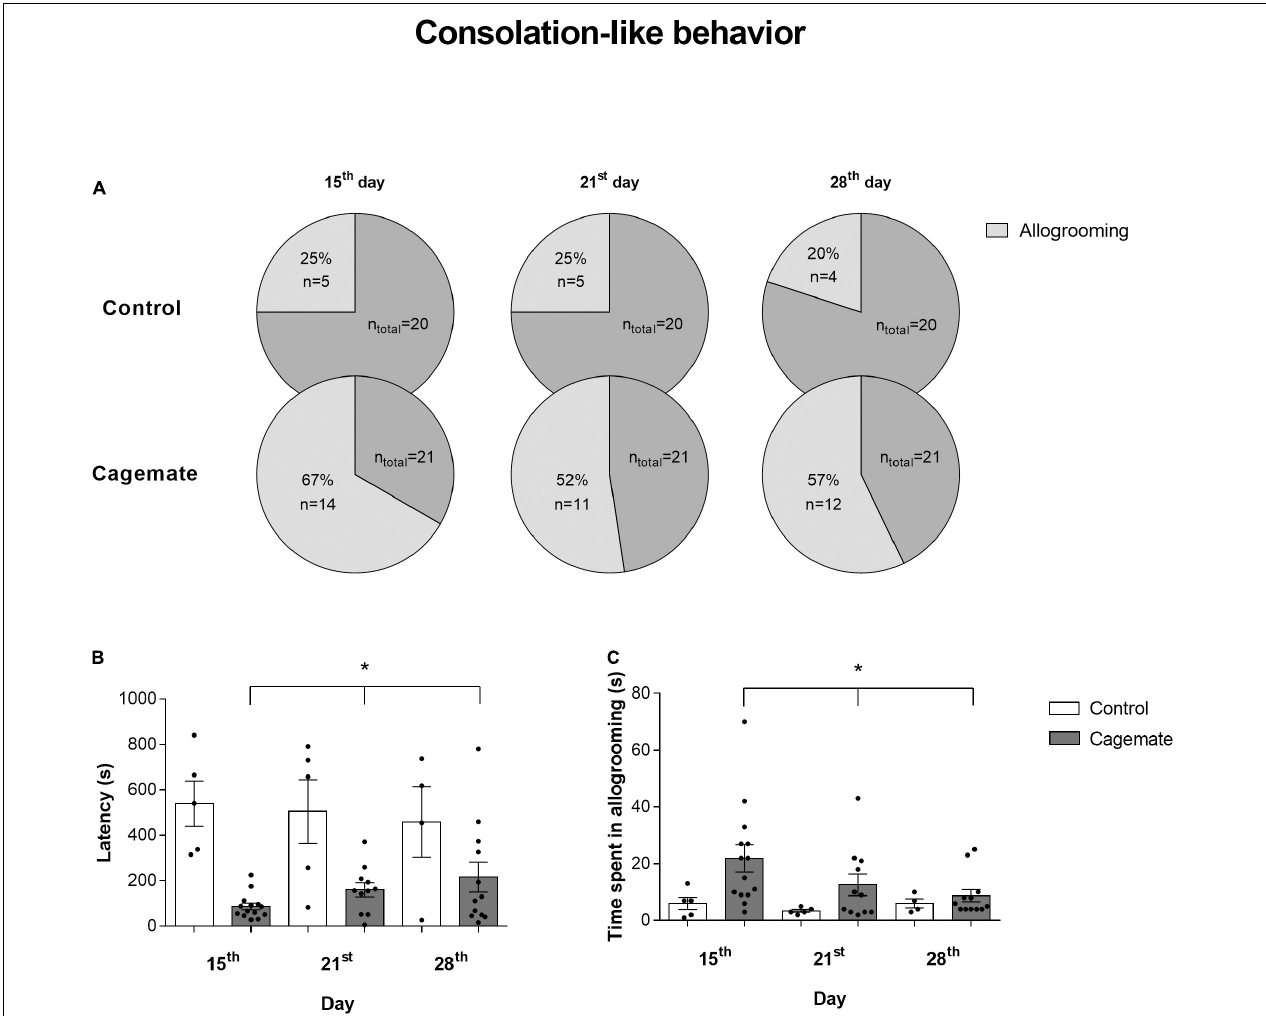
FIGURE 4 | The data in the panels (B,C) are presented as mean ± SEM. (A) Percentage of subjects that exhibited consolation-like behavior in the 15th, 21st, and 28th experimental days in control and cagemate groups; (B) latency to start and (C) time spent in allogrooming behavior during 15 min. * p < 0.05 vs. control group. Two-way ANOVA followed by Newman-Keuls post hoc test.